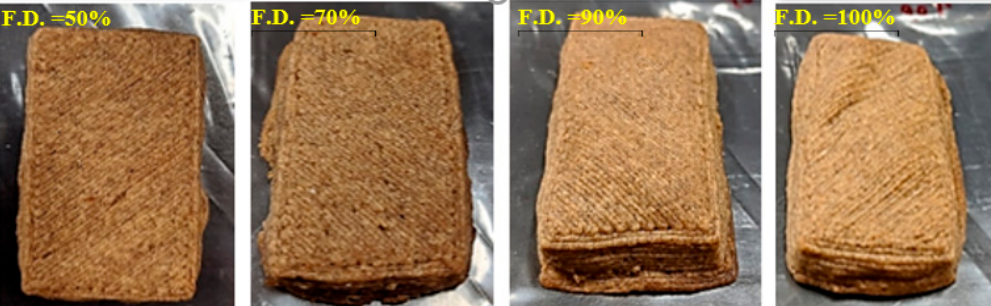
Figure 8. Representative images of cookies with different fill densities after baking.